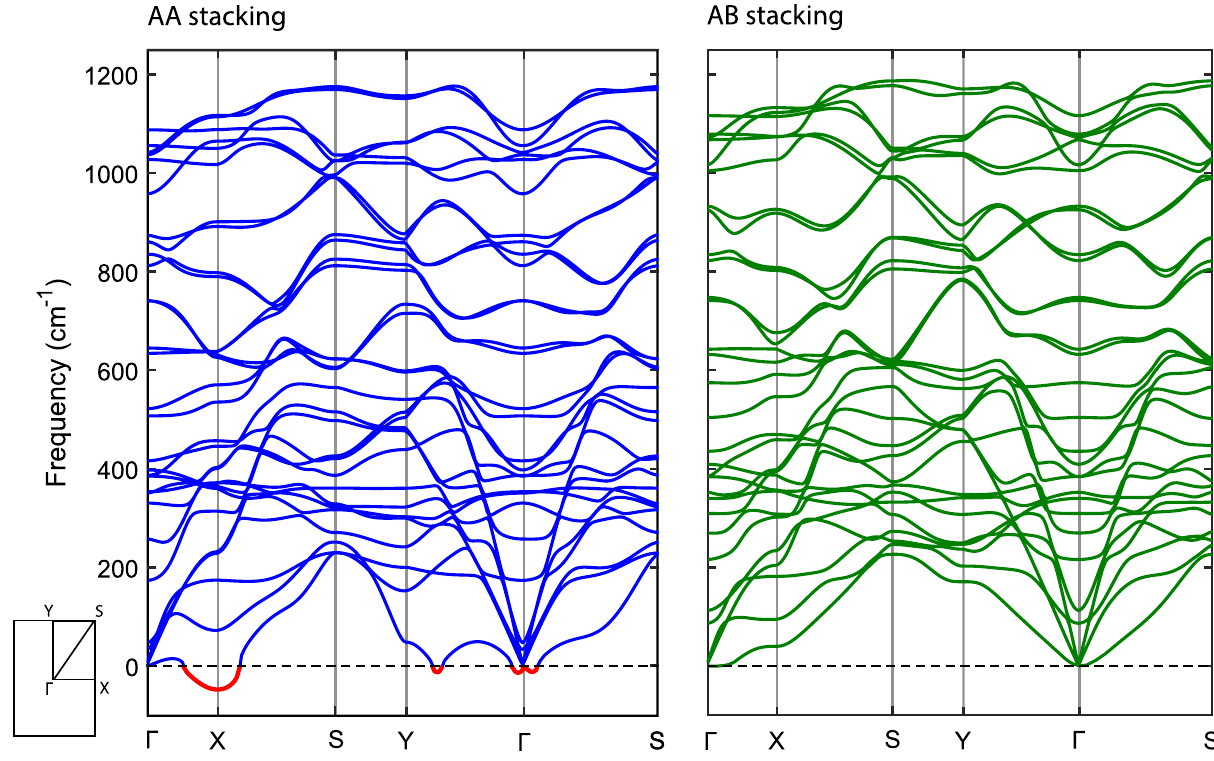
Figure 5. Phonon dispersion of bilayer β 12 borophene with AA (left) and AB (right) stackings. The Brillouin zone is also depicted in the inset.